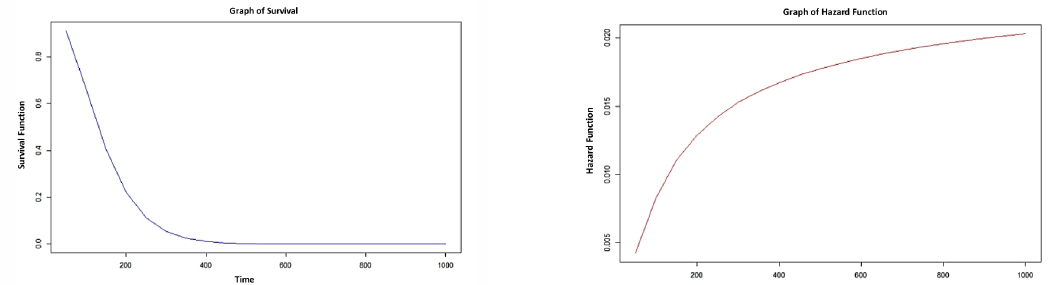
Fig. 4 . Graph of Survival function and Hazard function by MLE